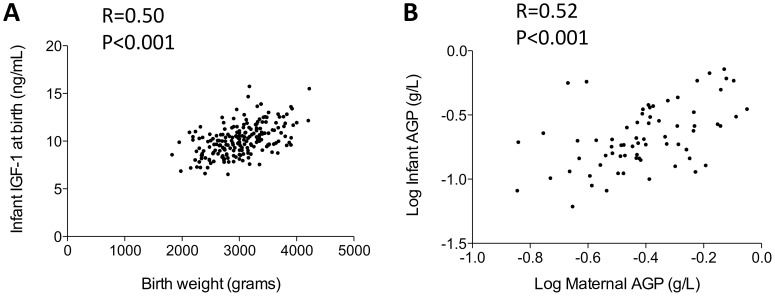
Influence of IGF-1 on birth weight and relationship between maternal and infant inflammation at birth.A: Relationship between infant levels of IGF-1, measured within 96 hours of birth, and birth weight. Spearman correlation is shown. B: Relationship between maternal and infant AGP levels measured in paired plasma samples collected within 96 hours of delivery. Spearman correlation is shown.